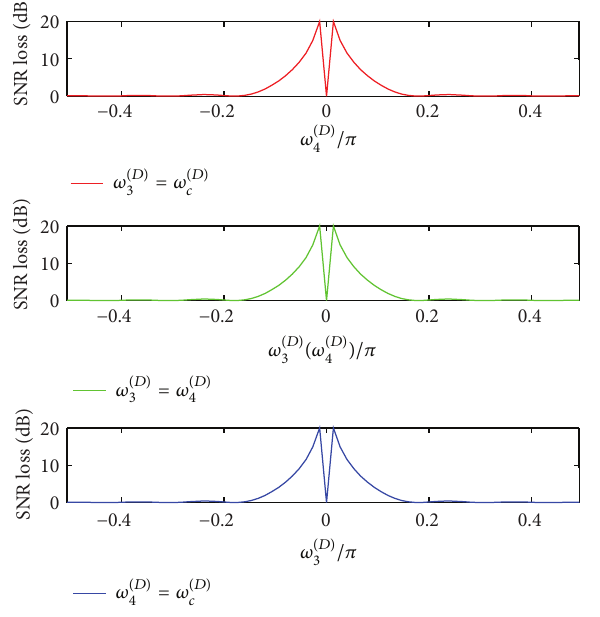
Figure 7: Sectional drawings of the three grooves in Figure 6.